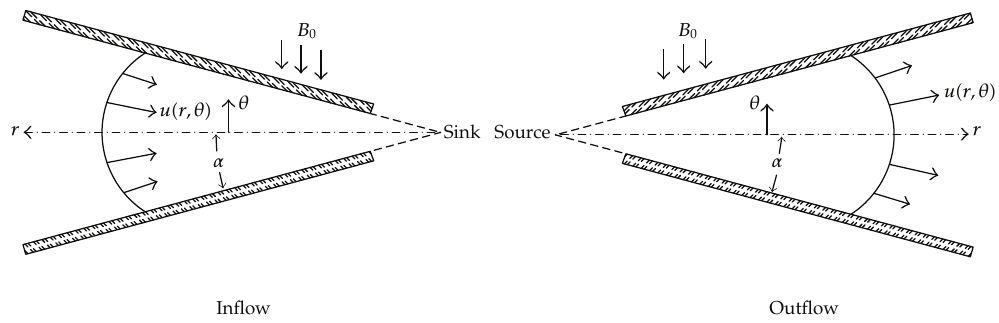
Figure 1: The schematic diagram of MHD flow through convergent or divergent